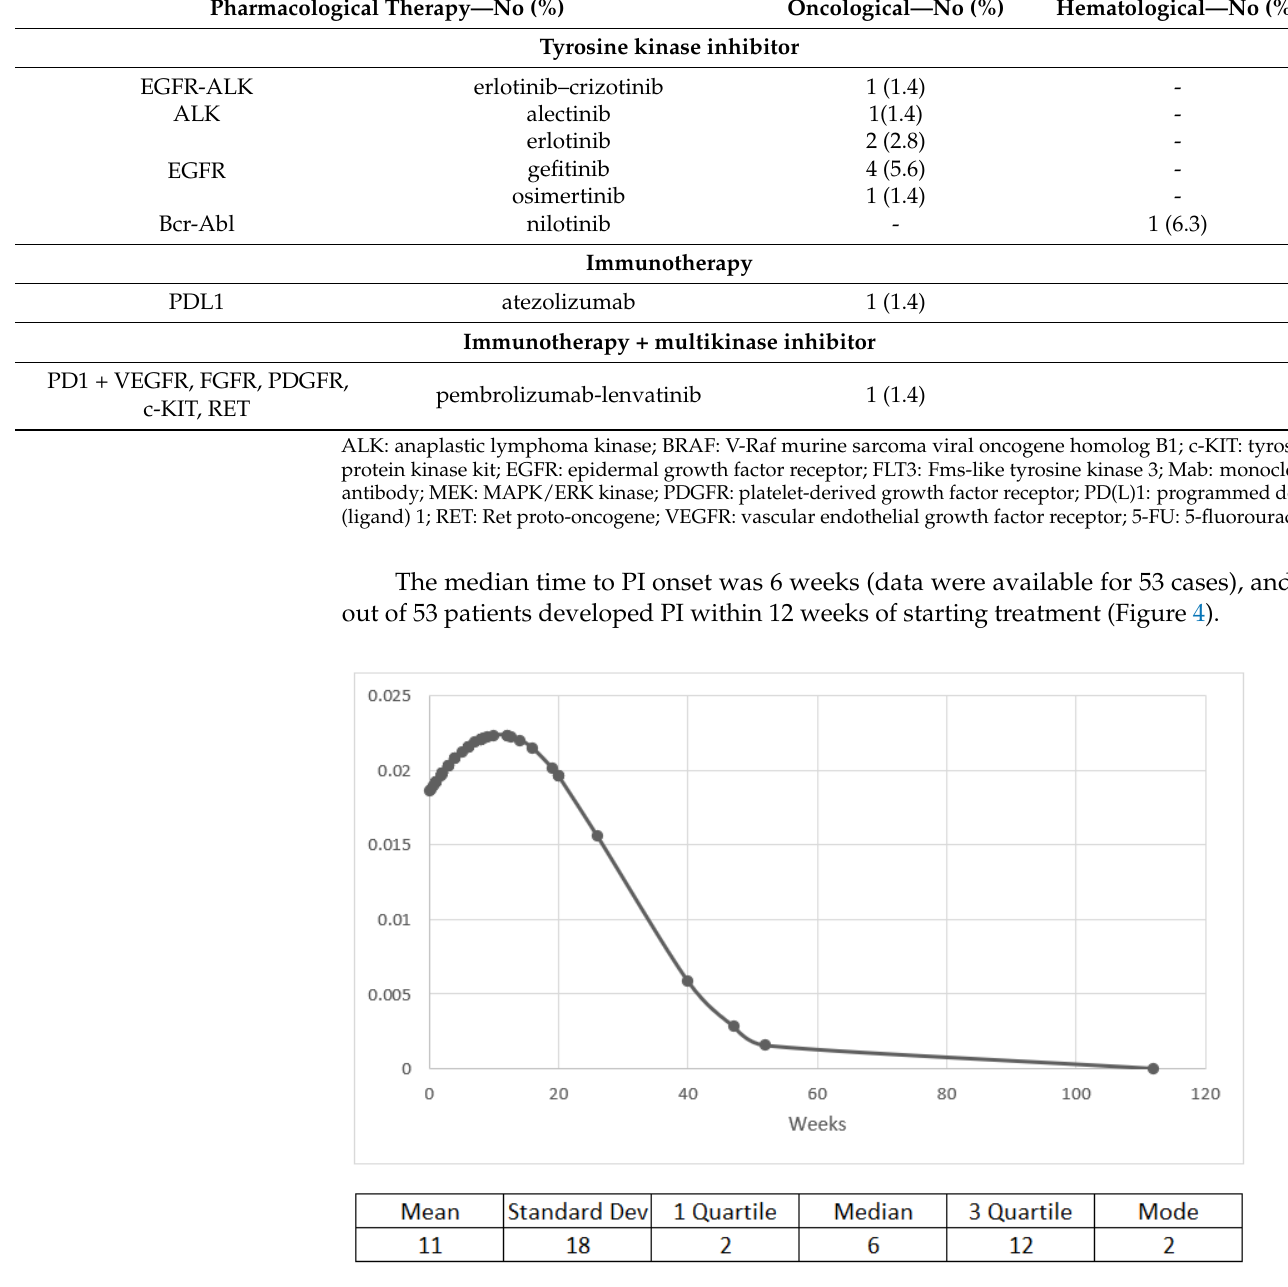
Figure 4. Time (in weeks) from treatment start to PI onset.